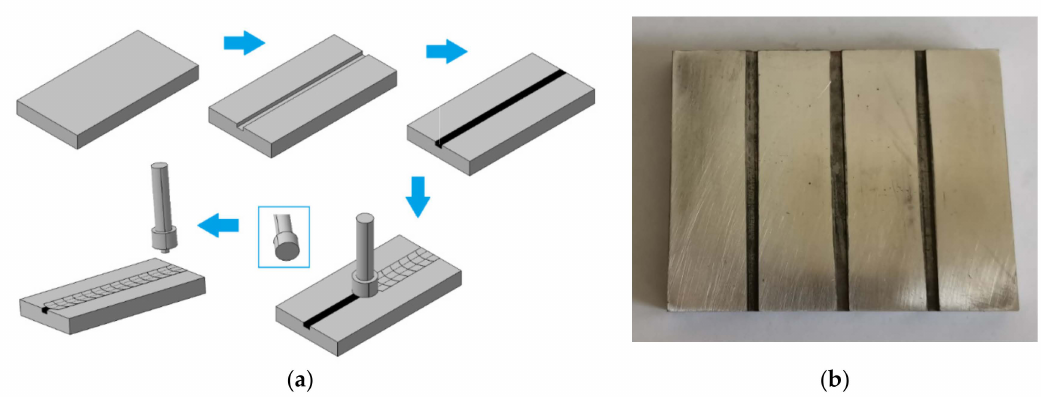
Figure 1. Diagram of groove method ( a ) (authors’ own drawing); sample for processing with groove method ( b